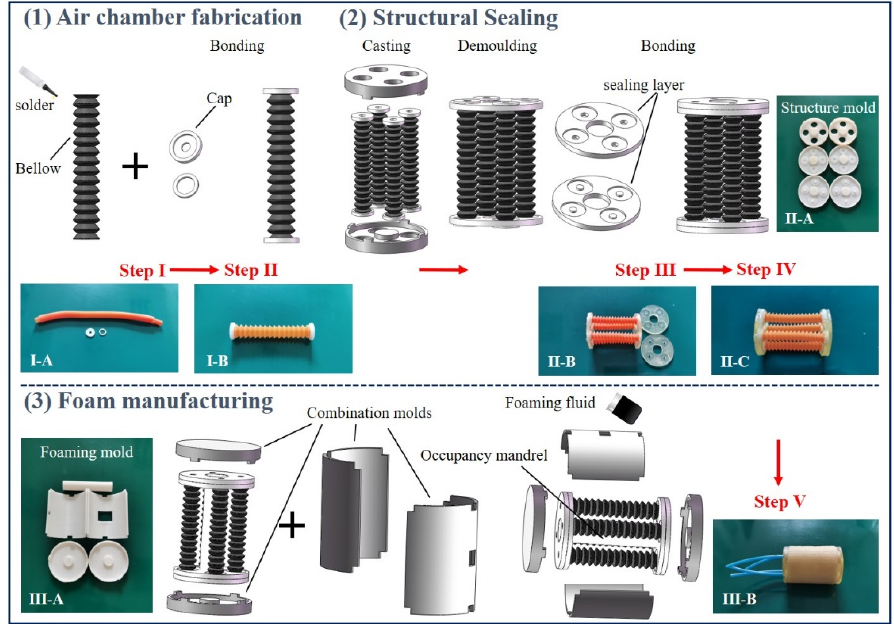
Figure 4. Actuator fabrication process.